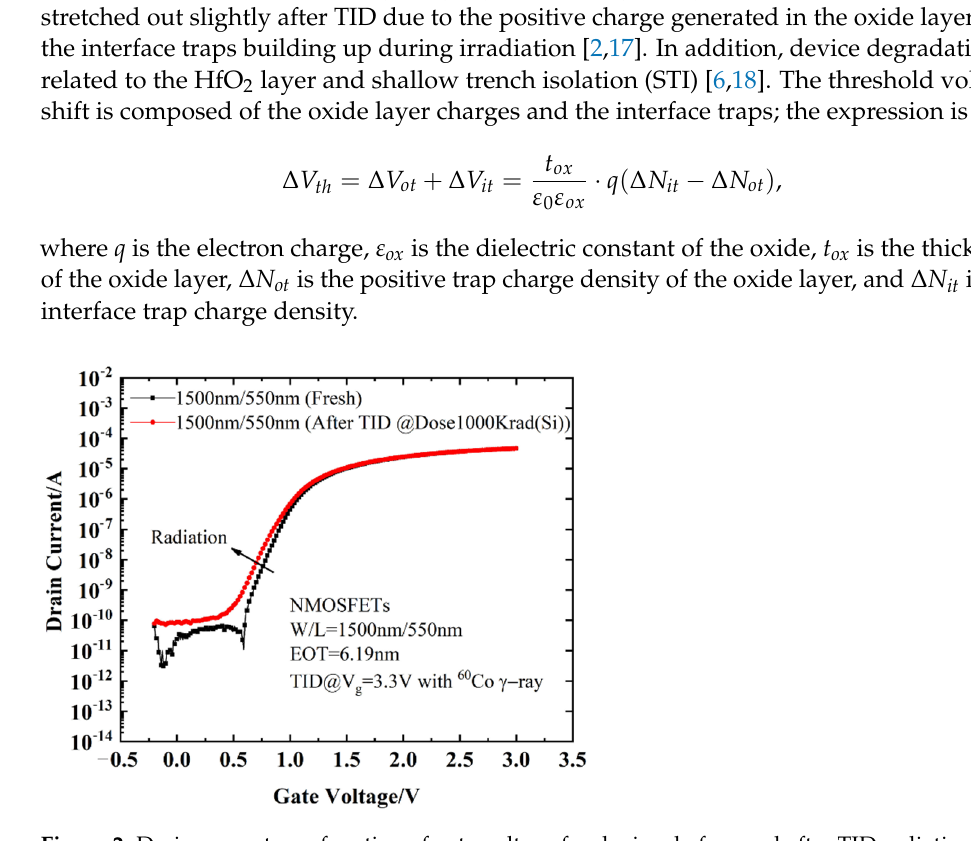
Figure 1. I − V characteristics for a typical NMOSFET in this work: ( a ) output characteristics and ( b ) transfer and transconductance curves.